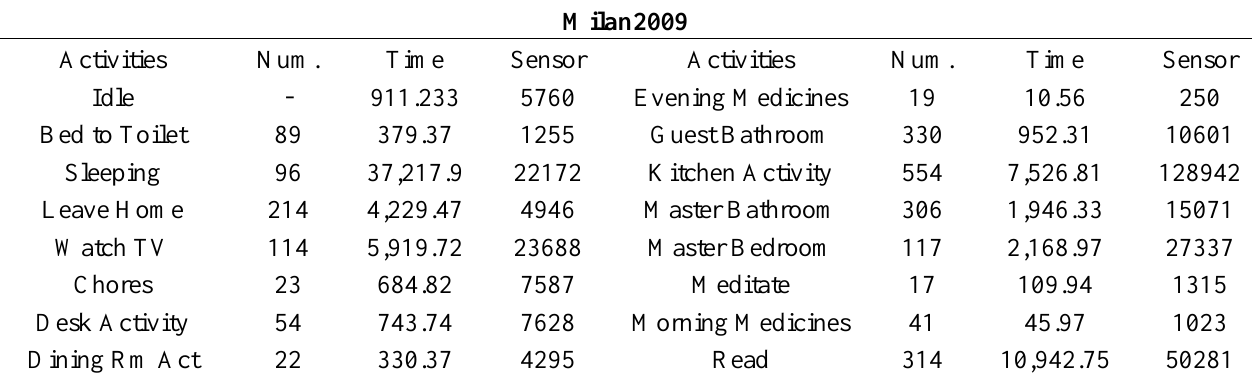
Table 3. Characteristics of the annotated activities of CASAS smart home